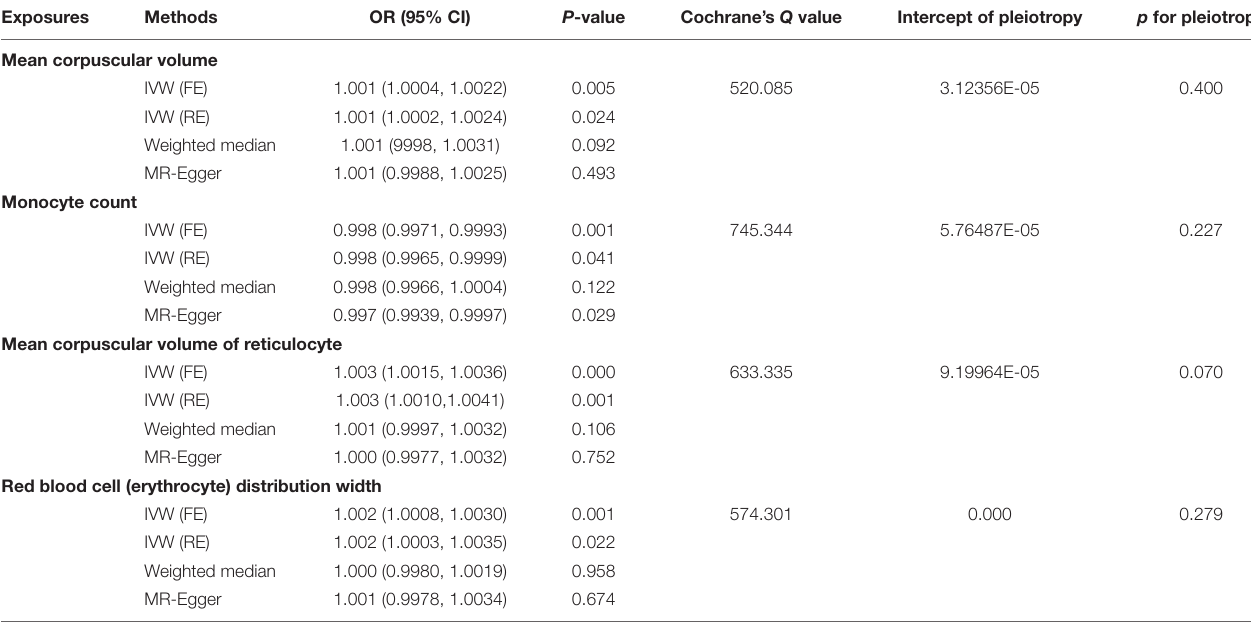
FIGURE 1 | The scheme of study design. TABLE 1 | Mendelian randomization estimates for the causal effect of cell indices on